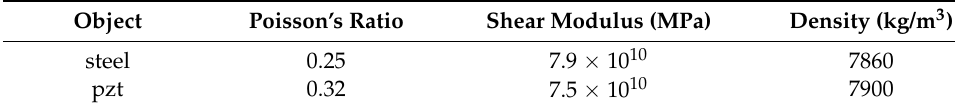
Table 1. Physical parameters.